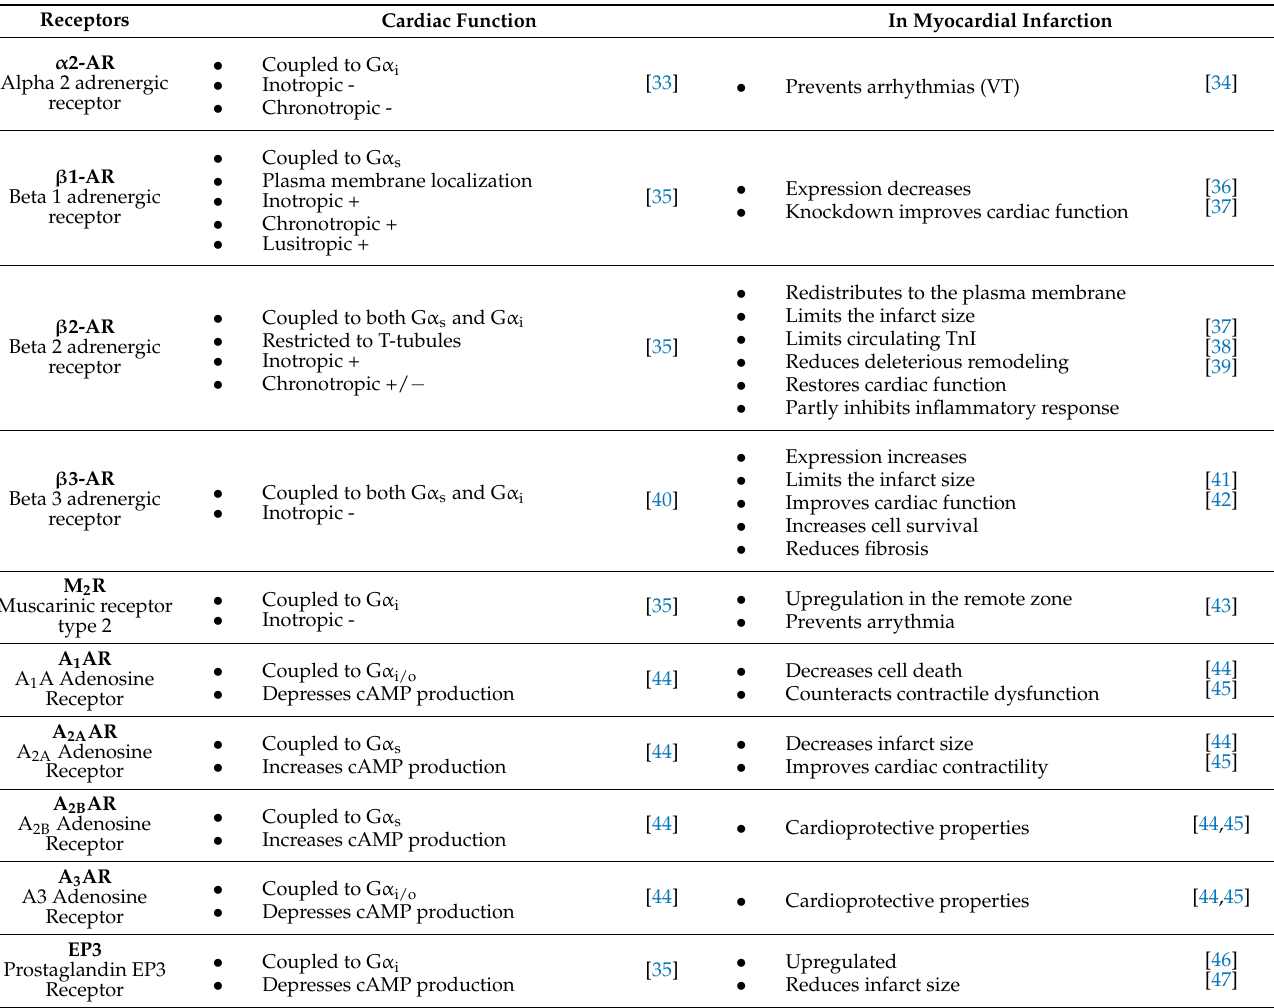
Table 1. Function of cardiac G α s and G α i protein-coupled receptors under physiological conditions and in myocardial infarction. α 2-AR: alpha 2 adrenergic receptor; VT: ventricular tachycardia; β 1-AR: beta 1 adrenergic receptor; β 2-AR: beta 2 adrenergic receptor; β 3-AR: beta 3 adrenergic receptor; M 2 R: muscarinic type 2 receptor; A 1 AR: A1 Adenosine Receptor; A 2A AR: A2A Adenosine Receptor; A 2B AR: A2B Adenosine Receptor; A 3 AR: A3 Adenosine receptor; GCCR: Glucagon Receptor; GLP1R: Glucagon Like Peptide 1 Receptor. Receptors Cardiac Function In Myocardial